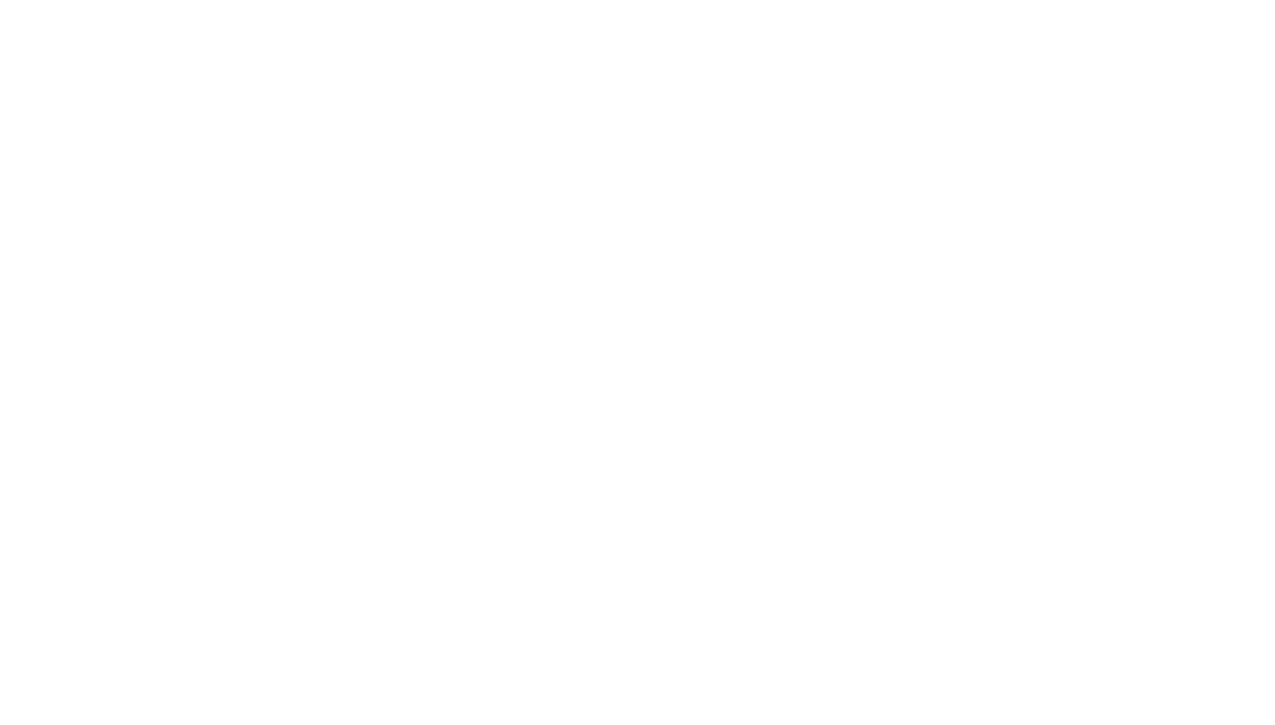
Frontiers in Cardiovascular Medicine | www.frontiersin.org